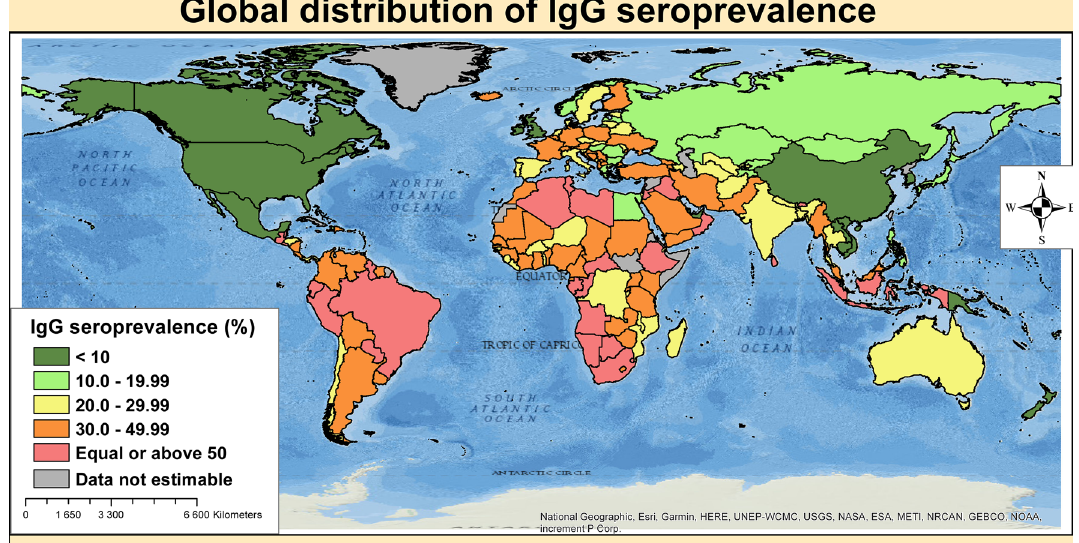
Figure 4. Global distribution of Toxoplasma gondii immunoglobulins G seroprevalence in pregnant women.